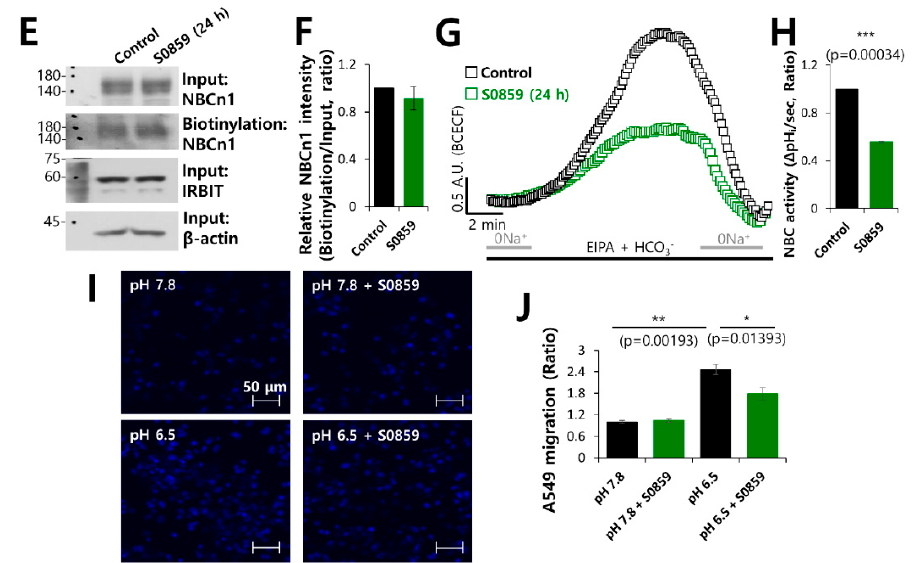
Figure 4. The NBC inhibitor, S0859, partially inhibited cell motility. ( A ) Time-dependent representative images of migration of A549 cells toward the agarose spots containing PBS (pH 7.4) in the presence or absence of the NBC inhibitor, S0859, at 20 μ M for indicated times. ( B ) Analysis of migration range per hour. Bars indicate the mean ± SEM of data ( n = 4). ( C ) MTT assay of A549 cells treated with 20 μ M S0859 for 72 h. ( D ) Immunostaining images of NBCn1 (red) and nucleus (DAPI, blue) in the presence of S0859 at 24 h. Scale bars represent 10 μ m. ( E ) Surface expression of NBCn1 24 h after treatment with 20 μ M S0859. IRBIT, β -Actin, and input NBCn1 were used as loading controls. ( F ) The bars indicate the mean ± SEM of relative NBCn1 intensity normalized by input NBCn1 ( n = 3). ( G ) NBC activity in A549 cells with (green open square) or without (control, black open square) 20 μ M S0859 at 24 h. Averaged traces are presented. ( H ) Bars indicate the mean ± SEM of NBC activity ( n = 3). ( I ) A549 migration was measured by a transwell membrane migration assay. The cells were incubated with the media and reagents indicated hereafter (bottom chamber: media of pH 7.8 and pH 6.5; upper chamber: with or without 20 μΜ S0859). Immunofluorescence staining of DAPI represents blue color. Scale bars represent 50 μ m. ( J ) Analysis of the total intensity of DAPI for determining A549 cell migration. The bars represent the mean ± SEM of data ( n = 4).